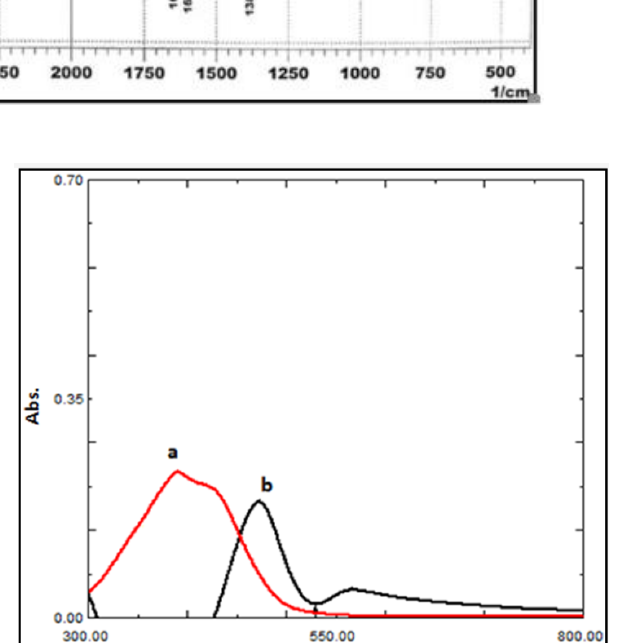
Fig. 8. Absorption spectrum of (a) Reagent NPAI = 5 x10 - 4 M (b) Cu(II)- NPAI complex, Cu (II) = 1 x10 -5 M , pH =